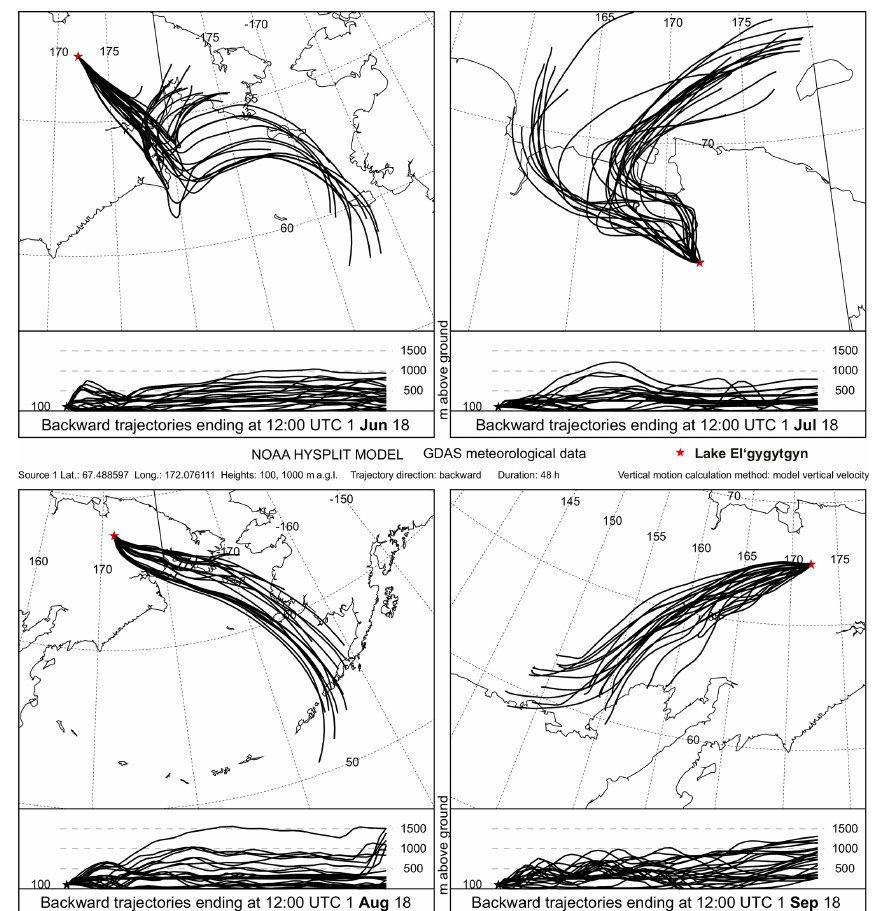
Figure 6. Aerosol backward trajectories of summer 2018 as examples of potential modern analogues for source areas of burning residues being deposited in Lake El’gygytgyn (star) during interglacial summers. The HYSPLIT transport and dispersion model was kindly provided by the NOAA Air Resources Laboratory and the READY website (http://www.ready.noaa.gov, last access: 18 June